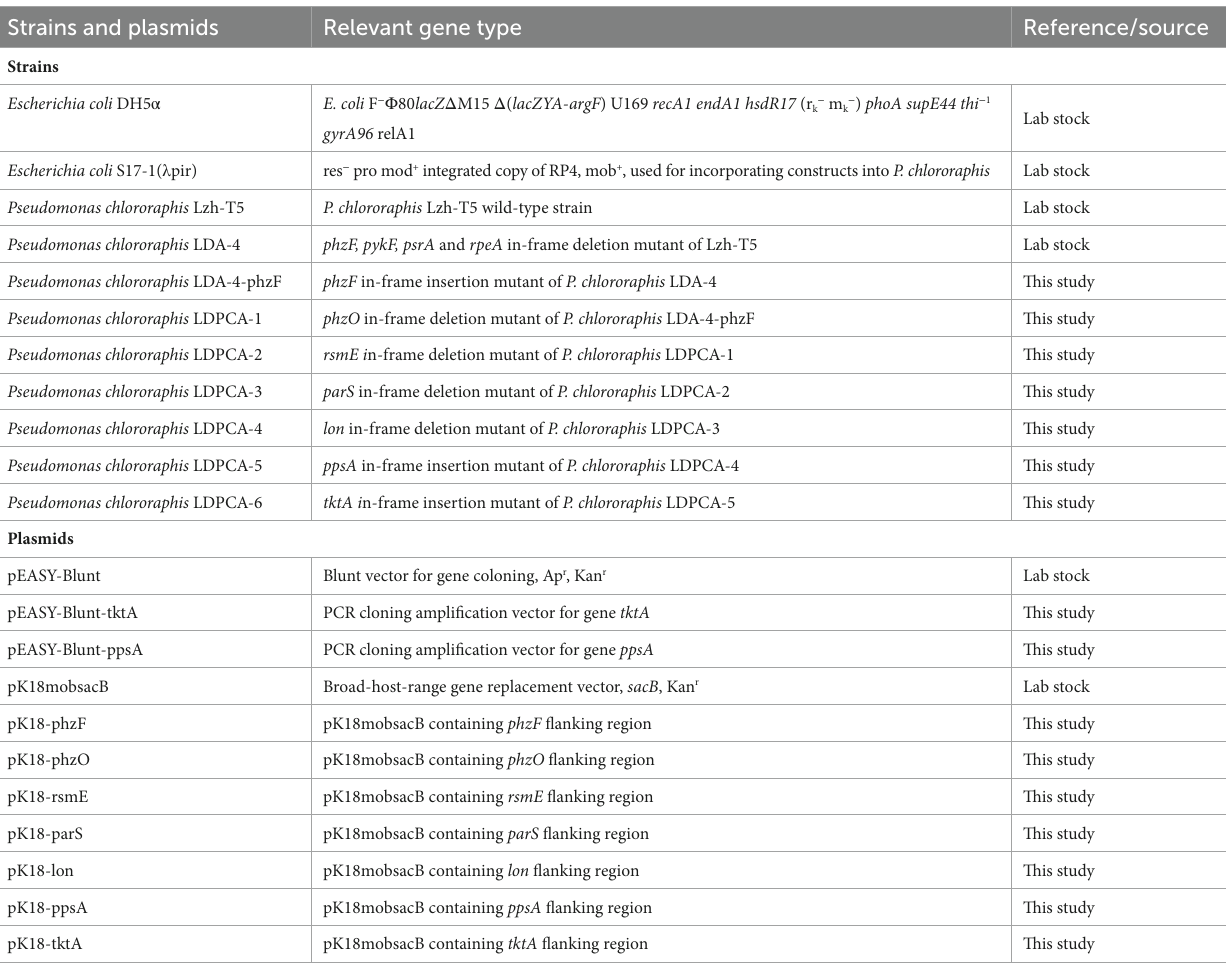
TABLE 1 Strains and plasmids used in this